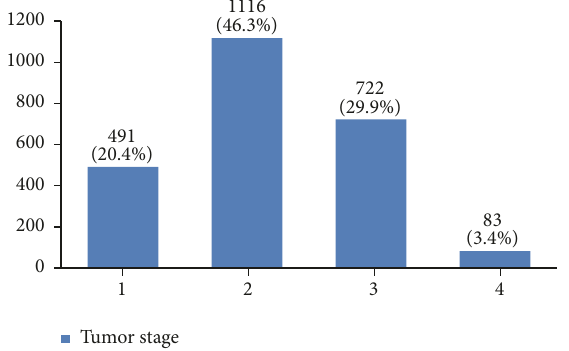
Figure 20: The tumor stage of the studied breast cancer cases.